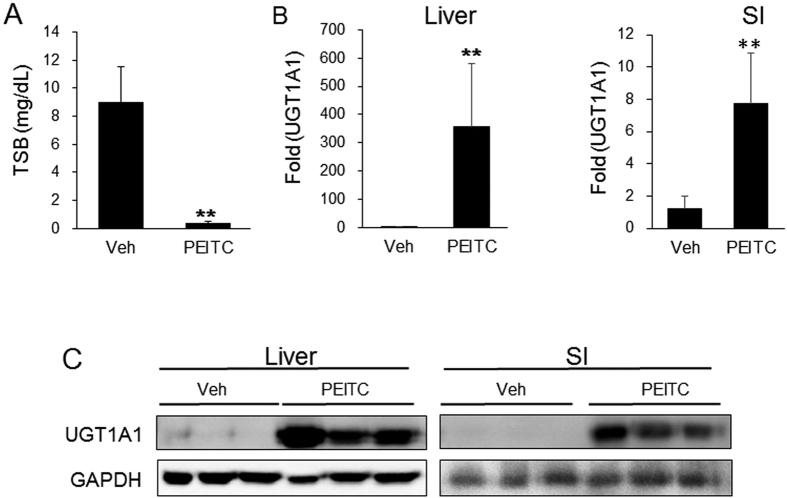
Induction of UGT1A1 by PEITC in neonatal hUGT1 mice.Ten day old neonatal hUGT1 mice were treated with 200 mg/kg PEITC or vehicle by p.o. administration. (A) Forty eight hours after the treatment, total serum bilirubin (TSB) levels were taken. (B) Liver and small intestine (SI) were pulverized under liquid nitrogen and used for the preparation of total RNA or whole tissue extracts. From RNA preparations, UGT1A1 gene expression was determined by real time PCR and expressed as fold induction. (C) Using whole tissue extracts, Western blots were performed from liver and SI tissue to examine UGT1A1 expression and imaged on a BioRad ChemiDoc Touch Imaging System. The bands have been cropped from the full-length blots but not enhanced in anyway (S4). Values are the means of ±SD (n > 3). Statistically significant differences between vehicle (Veh) and PEITC are indicated by asterisks (Student t test: **P < 0.01).